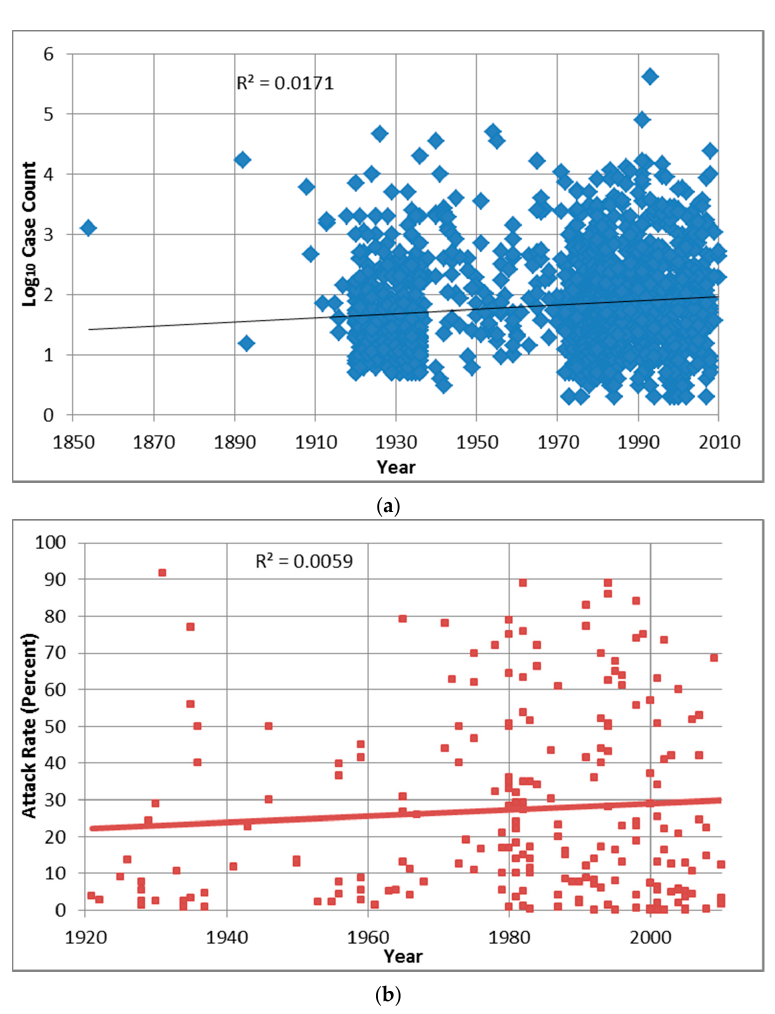
Figure A1. Distribution and correlation of outbreak log 10 case count ( a ) and attack rate ( b ) with year.